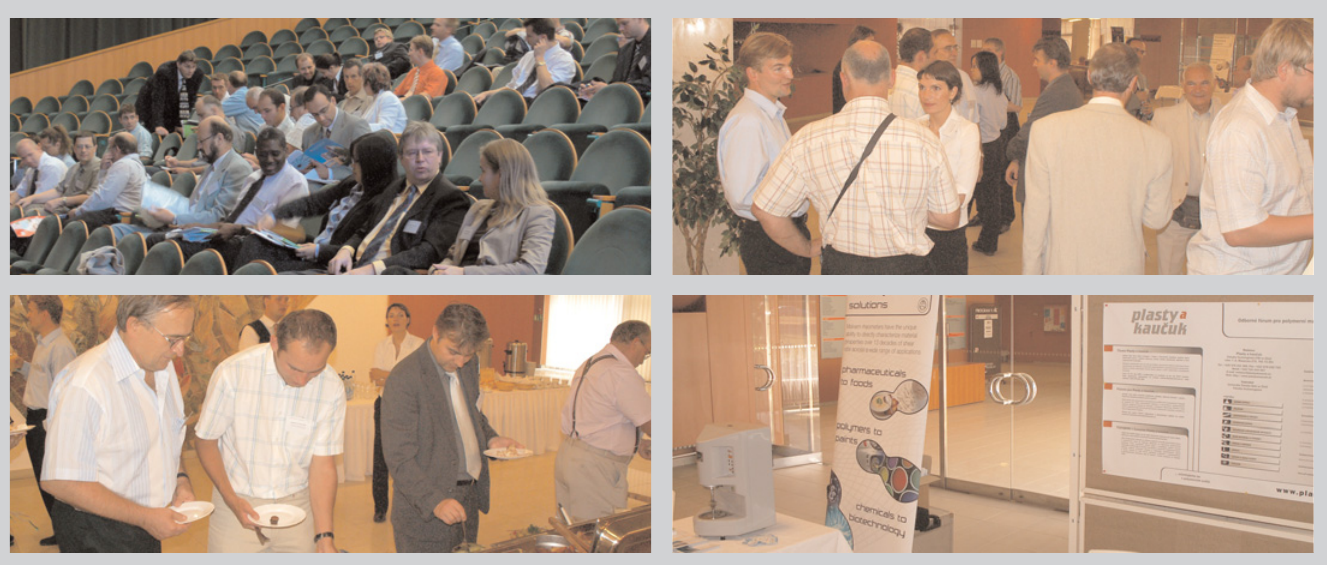
DOI: 10.1515/arh-20 0 8 -00 2